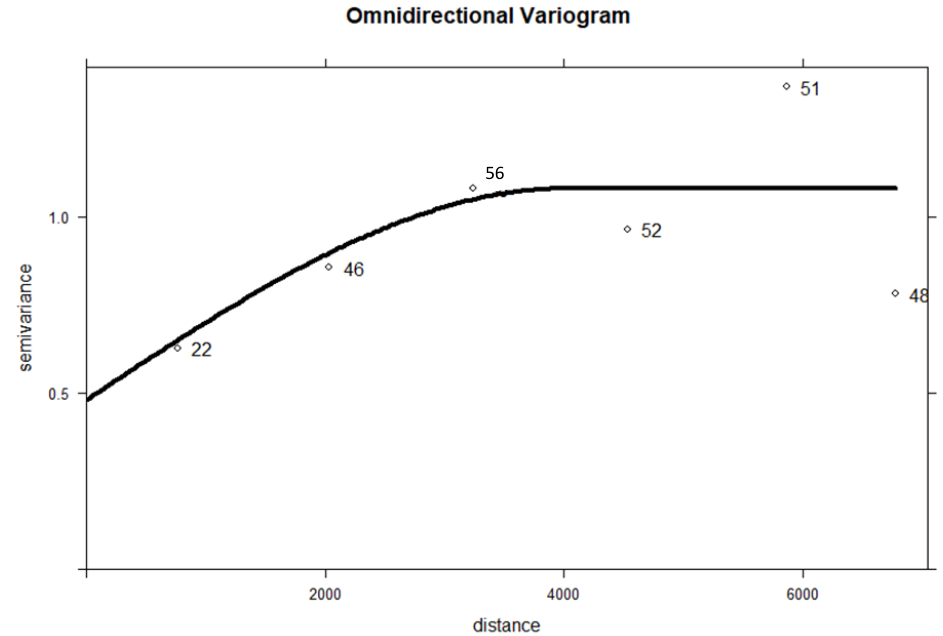
Figure 10. Omnidirectional variogram fitted with directional spherical model variogram by cross- validation.